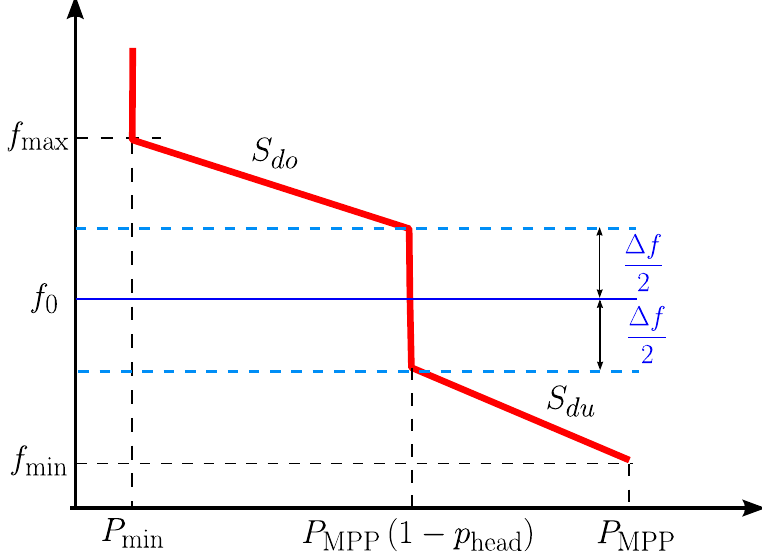
Figure 10. Droop curve and operation points of DRES at a given time instant.